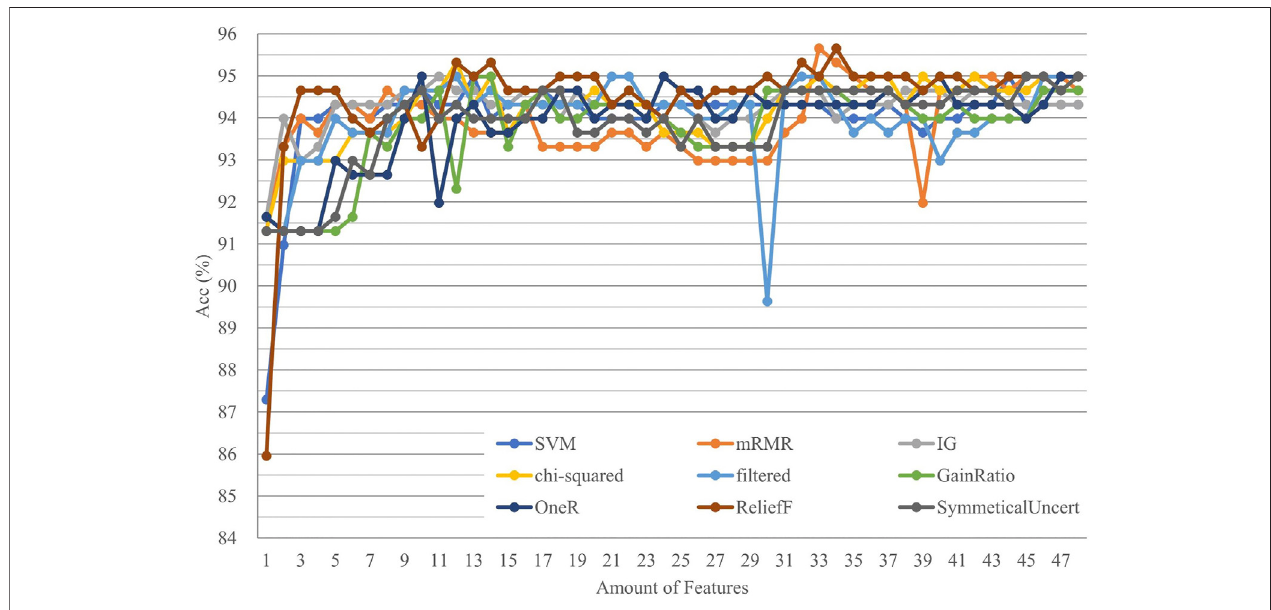
FIGURE 3 | Accuracy trend in the second-layer feature selection.